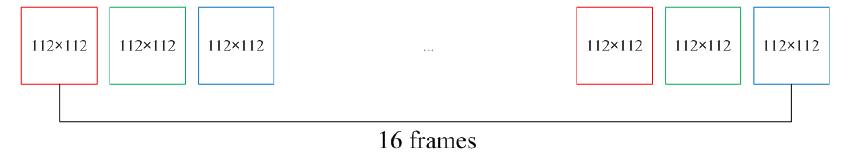
Figure 2. Structure of one tensor (3 color channels × 16 frames × 112 pixels × 112 pixels).